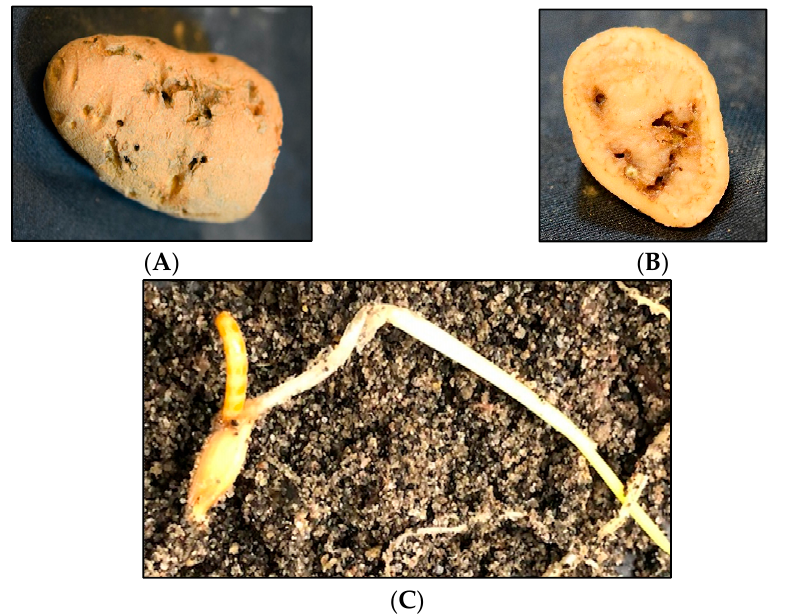
Figure 2. Feeding damage by the sugar beet wireworm, Limonius californicus . ( A , B ) Wireworm feeding damage in a potato, and ( C ) feeding on a barley seed.